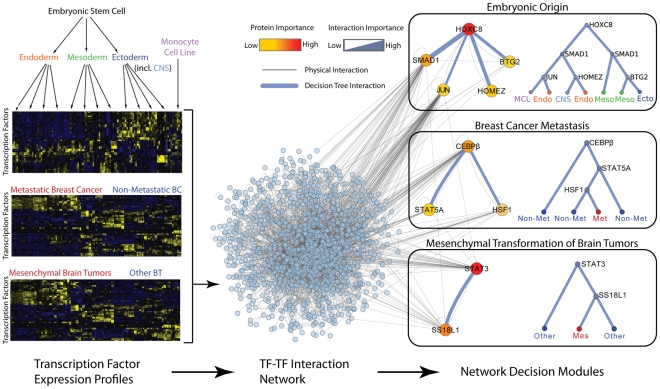
Network decision modules underlying embryonic origin, breast cancer metastasis and mesenchymal transformation of brain tumors.Expression profiles for each of the three case studies are combined with a network of protein-protein interactions among human transcription factors. Network-guided forests are used to identify key network modules that are most important for correct sample classification (representative modules are shown for each study). Grey edges indicate physical protein-protein interactions, blue edges indicate protein combinations that often co-occur in the same decision trees and are most important for classification (as indicated by the permutation test). Node color indicates protein importance whereas edge width indicates the importance of a protein combination. Each module is assigned a decision tree that specifies the output of the module based on the activity of its genes (see also Figure S1).